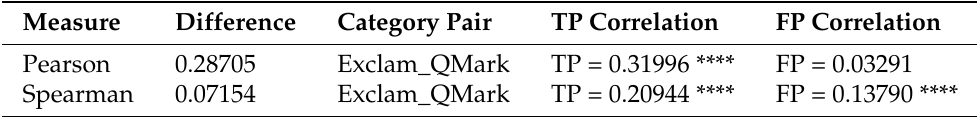
Table 52. Exclamation Markers and Question Markers in Medium.